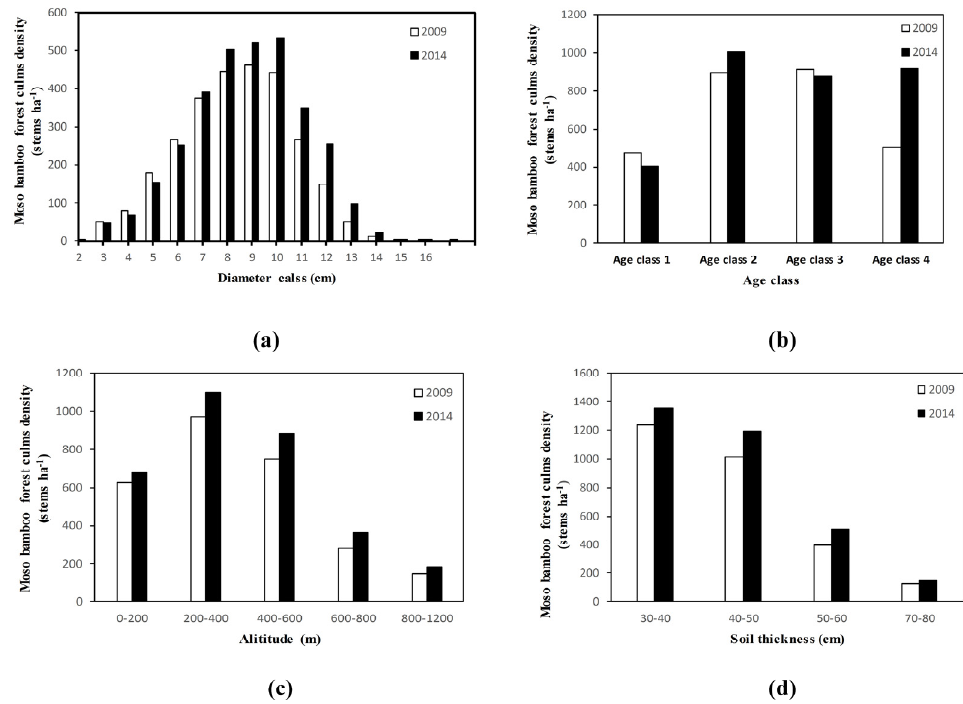
Figure 2. Distribution of Moso bamboo forest culms. ( a ) represents the distribution in different diameter class; ( b ) represents the distribution in different age class; ( c ) represents the distribution in different altitude; (d) represents the distribution in different soil thickness.